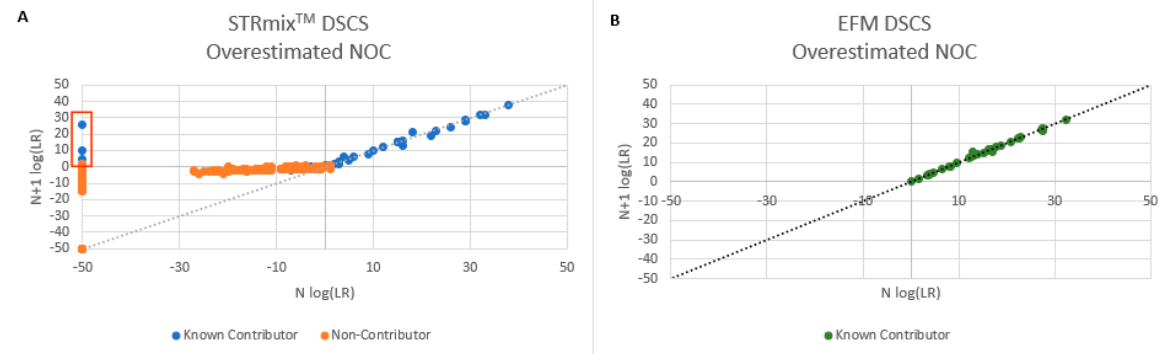
Figure 12. Overestimating the number of contributors to single source DSCS subsamples. STRmix TM ( A ); EuroForMix ( B ); Note: Non-contributor profiles were not run with EFM. LR = 0 plo tt ed as − 50.